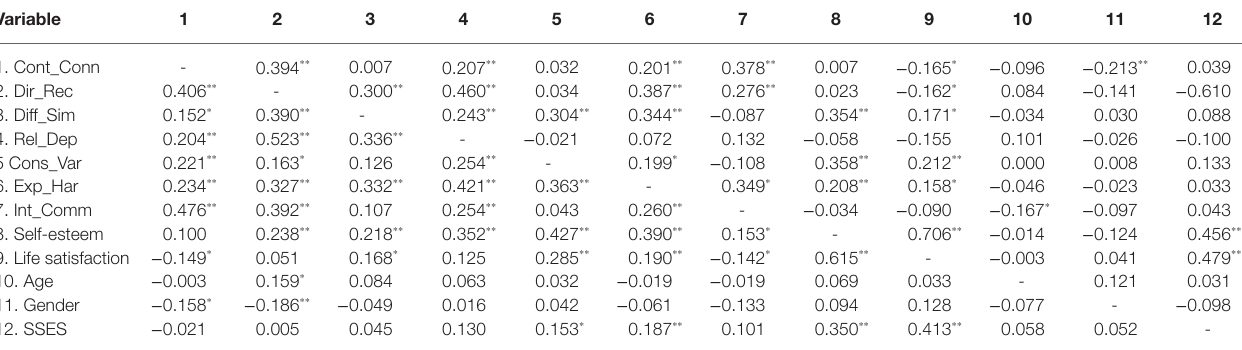
TABLE 8 | Bivariate correlations between all variables in Study 2 by each culture. Variable